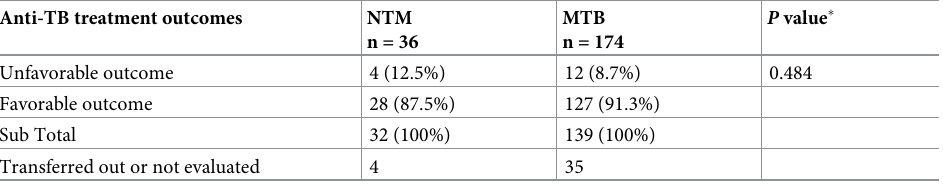
Table 3. Treatment outcomes among PLHIV with NTM or MTB positive culture treated with anti-TB treatment. Anti-TB treatment outcomes